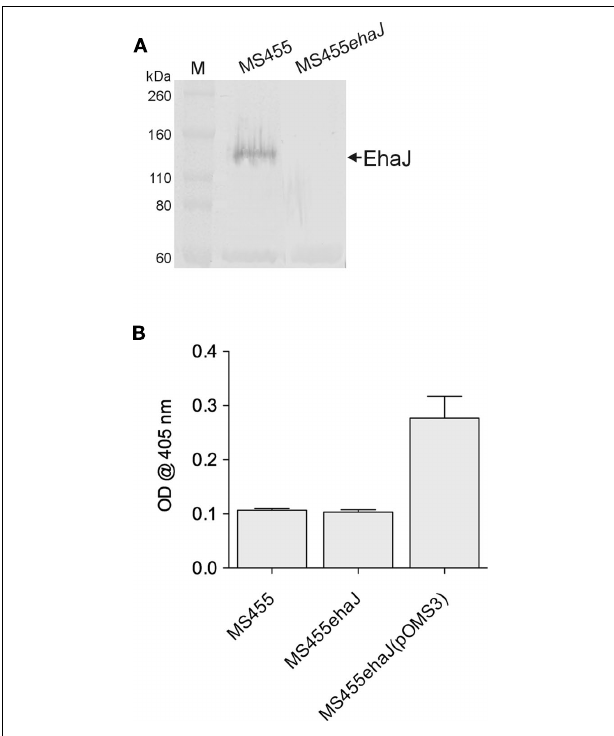
FIGURE 5 | (A) Western blotting with rabbit antiserum specific for the passenger domain of demonstrates expression of EhaJ in wild-type EPEC strain MS455 and loss of EhaJ in MS455 ehaJ . Molecular mass (kDa) for the protein markers (M) [Novex Sharp Standards, Invitrogen] is shown on the right. (B) Wild-type strain MS455 did not bind strongly to the MaxGel protein mixture in an ECM binding assay and inactivation of EhaJ in strain MS455ehaJ did not reduce binding to ECM proteins in this assay ( P = 0.55). However, over-expression of ehaJ (but not egtA ) in MS455 ehaJ (pOMS3) lead to a small but reproducible increase in binding to the MaxGel protein mixture ( P = 0.008). An unpaired t -test was used for statistical comparisons using GraphPad Prism